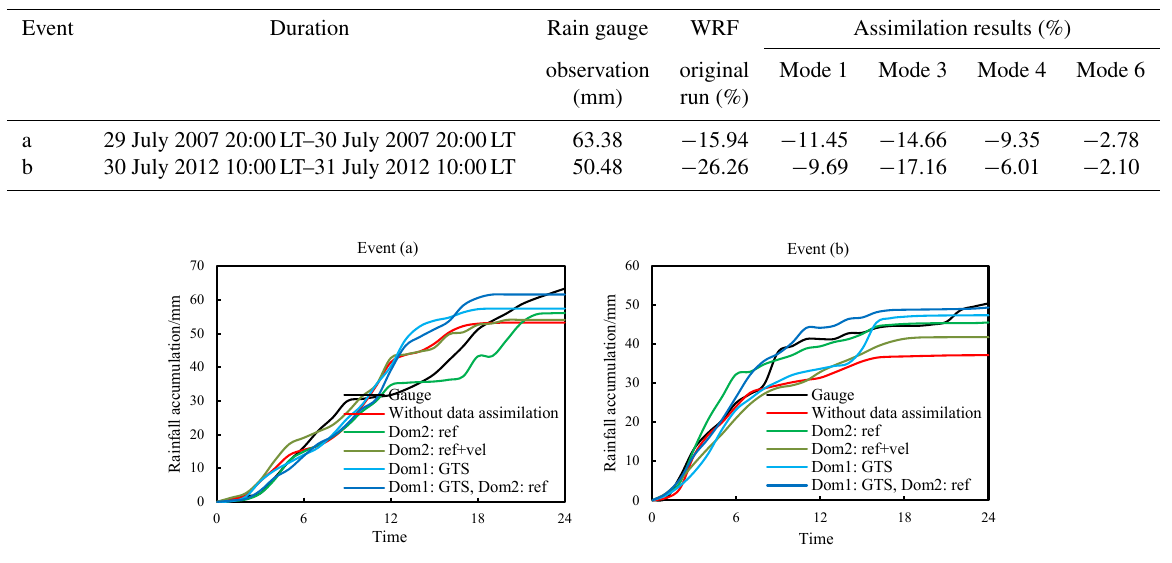
Table 6. The two storm events of the analogue catchment and the relative errors of the forecasted rainfall from different data assimilation modes.